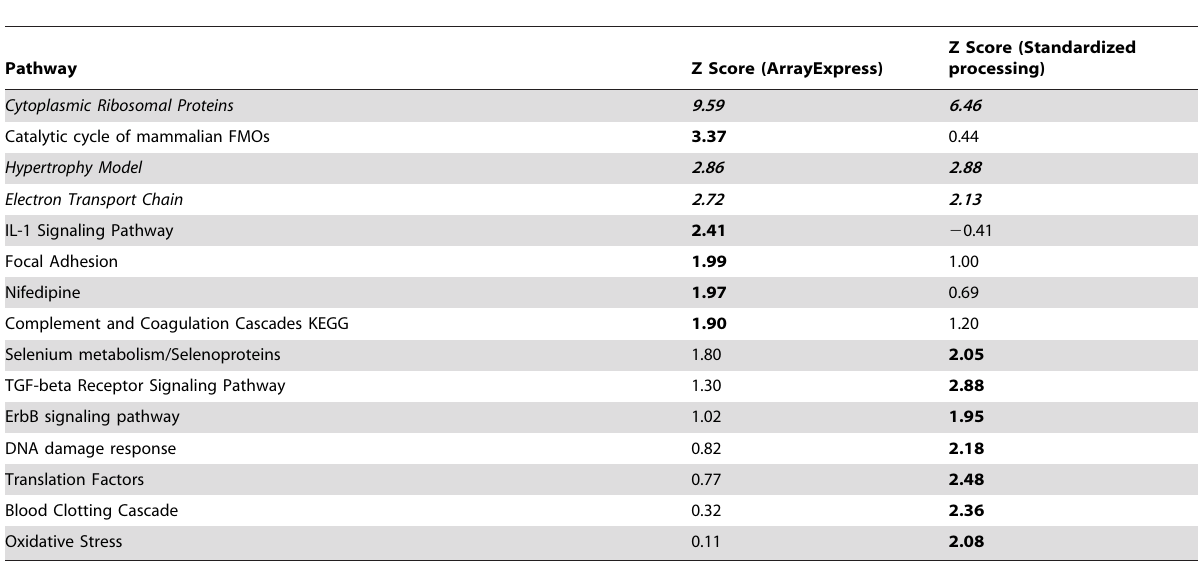
Table 6. PathVisio results of significant pathways found in the dataset by Best et al. comparing processed data provided by ArrayExpress with the reprocessed data after quality